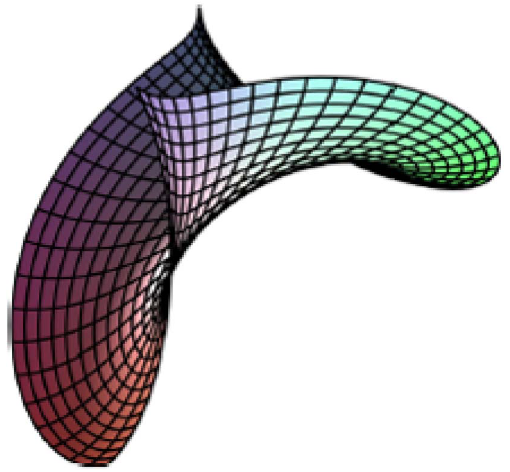
Figure 9. The canal surface P T ( s , h ) constructed by the tangent indicatrix T of a